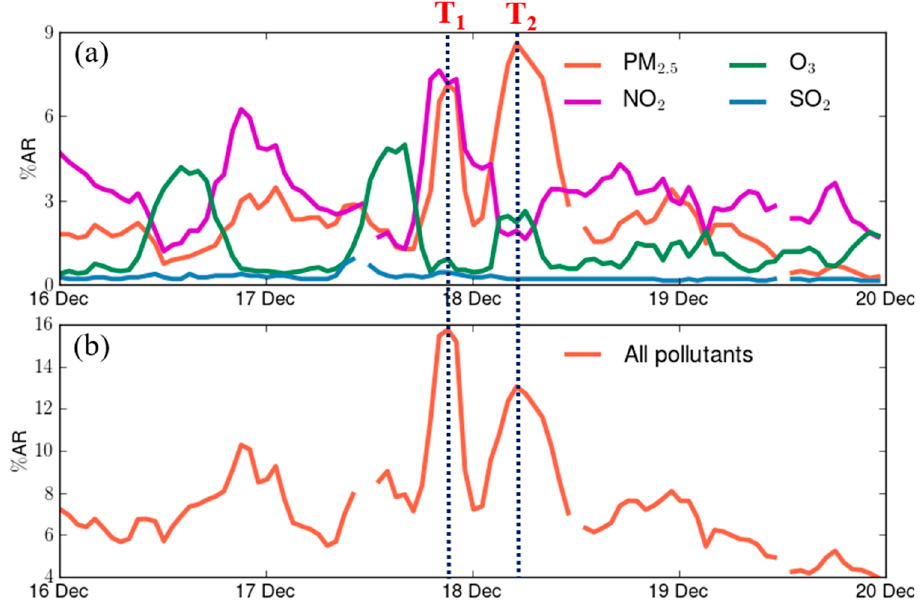
Figure 7. Time series of ( a ) %AR of mortality for the four pollutants and ( b ) their combined %AR in Fuzhou from 16 to 19 December 2019. Results were obtained using the 𝛽 coefficients of the global in Fuzhou from 16 to 19 December 2019. Results were obtained using the β coefficients of the review. global